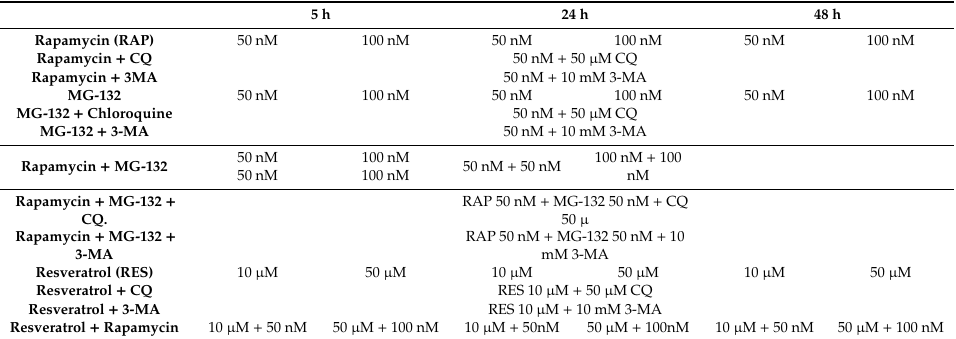
Table 1. Treatment protocols used in the